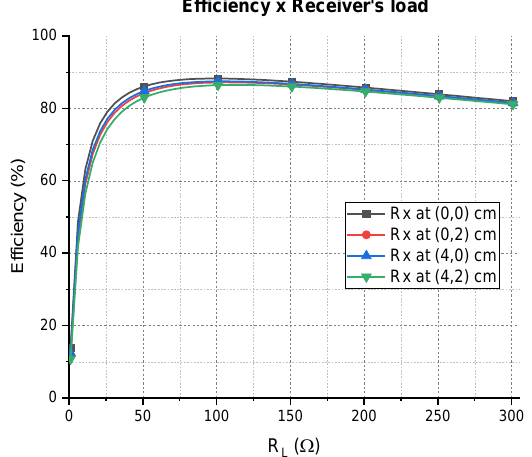
Figure 16. Efficiency vs. load resistance for four different positions of the receiver. The Rx is connected to an SP compensation network and the Tx is always adapted to 50 Ω .